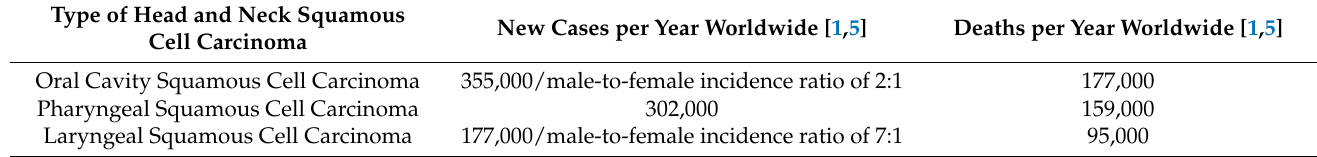
Table 1. Estimated numbers of new cases and deaths per year worldwide for the most common types of head and neck squamous cell